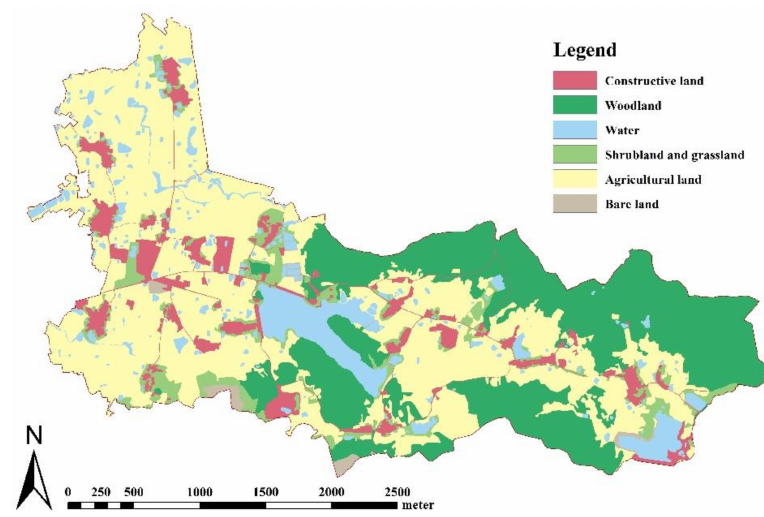
Figure 3. Land use of Paifang Village in 2010.